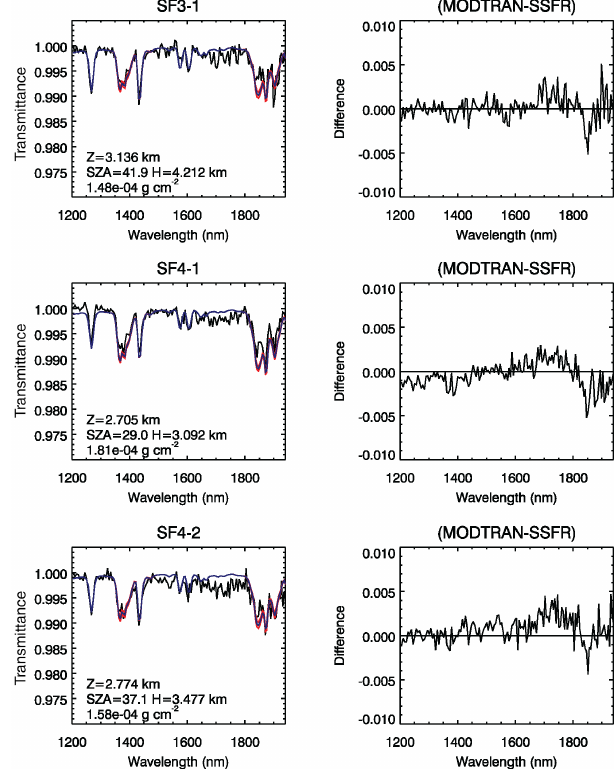
Figure 7. Same as Fig. 6 for profiles during the third and fourth ATTREX science